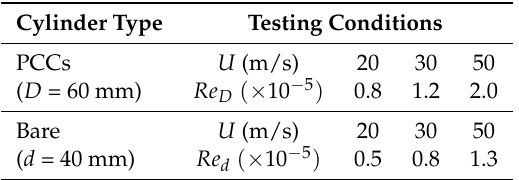
Figure 6. Schematic diagram representing the testing configuration in the 550 mm × 400 mm aeroacoustic wind tunnel in CARDC. Table 1. Experimental flow conditions for the bare and